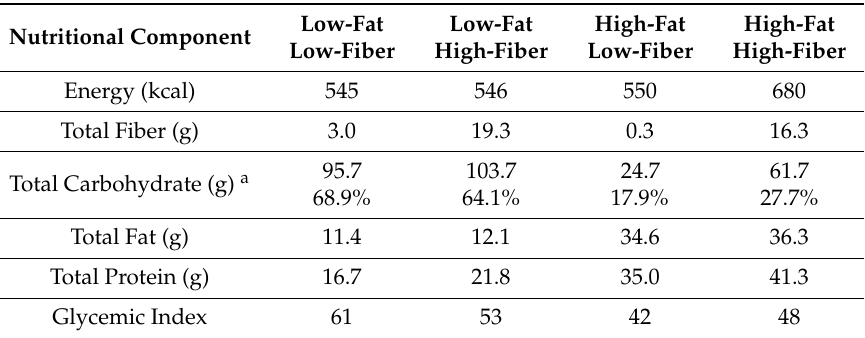
Table 2. Composition of study